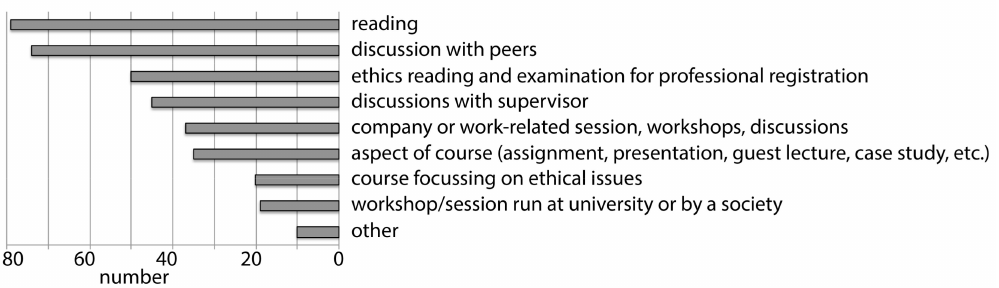
Figure 3. Ethical considerations observed by participants, and sorted from most frequent to least frequent responses.